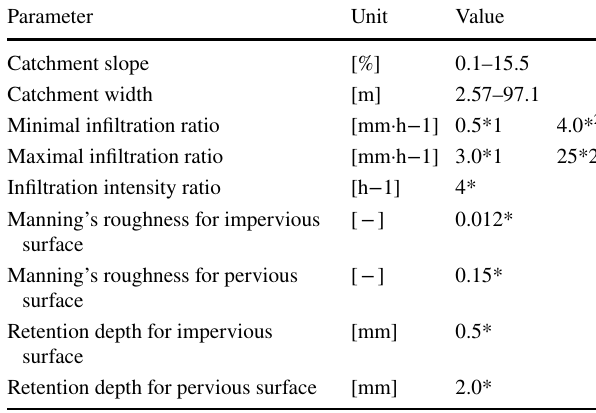
Table 1 Parameters of